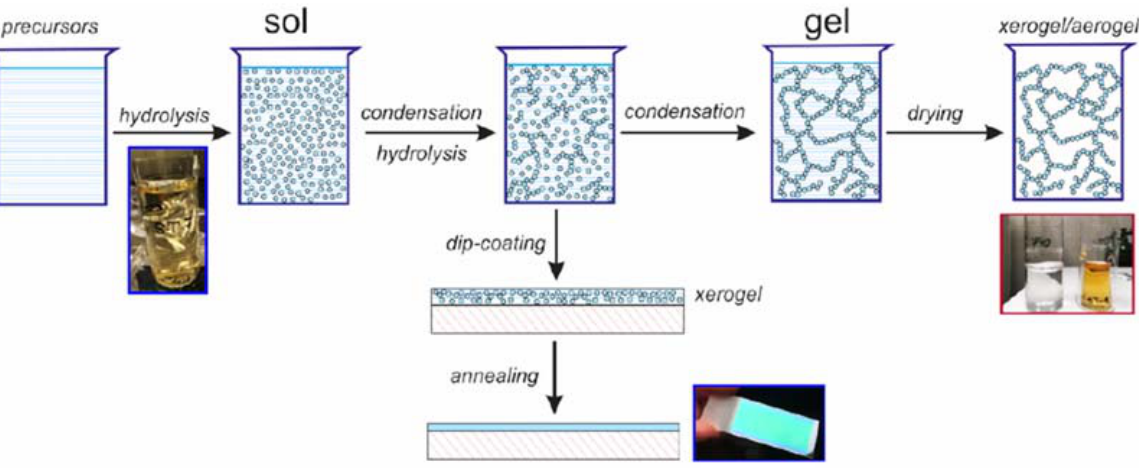
Figure 8. Graphical illustration of the sol-gel fabrication technique for SiO 2 -TiO 2 WG layers [35].